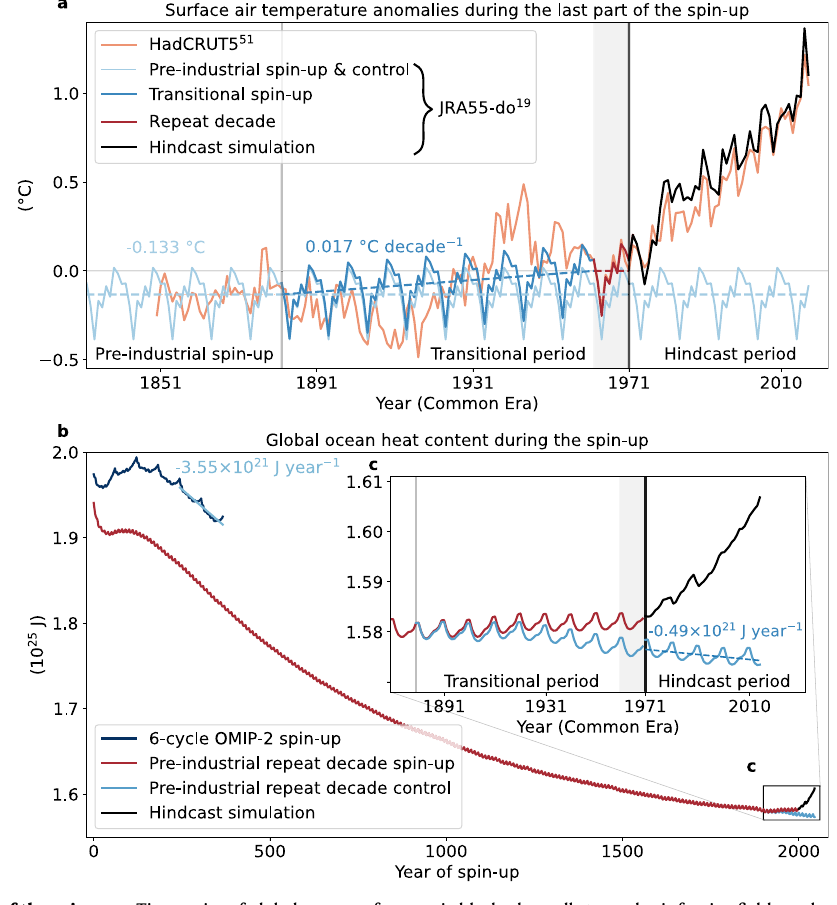
inblackwhereallatmosphericforcing fi eldsevolveovertime).Theparallelcontrol simulationisobtainedbycontinuingthemodi fi edpre-industrialspin-up(lightblue line) unchanged through the transitional period past 1972. b Time series of global oceanheat content during the fi ve-cycle OMIP-2 spin-up (dark blue line,10 25 J, and lineartrendoverthelasttwocycles, − 3.55×10 21 Jyear − 1 )andthepre-industrialspin- up(redline,10 25 J).Theoffsetbetweenthetwotimeseriesatyear1ofthespin-upis due to the use of updated temperature fi elds and bathymetric changes in the repeat decade spin-up. c Inset of the last part of the spin-up, showing the transi- tional and hindcast periods with the 1960s period shaded in grey. The control simulation is given in light blue with its linear trend of − 0.49×10 21 J year − 1 over 1972 – 2017. The black line is the ocean heat content in the full forcing simulation initialised in